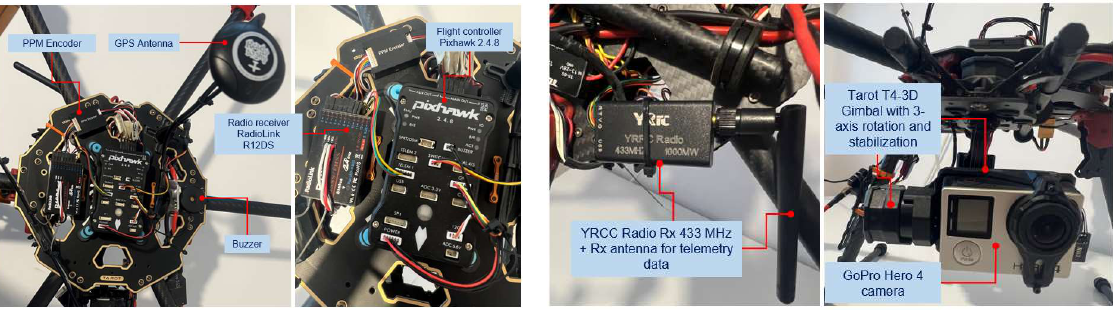
Figure 2. Variant v2 of the hexacopter.